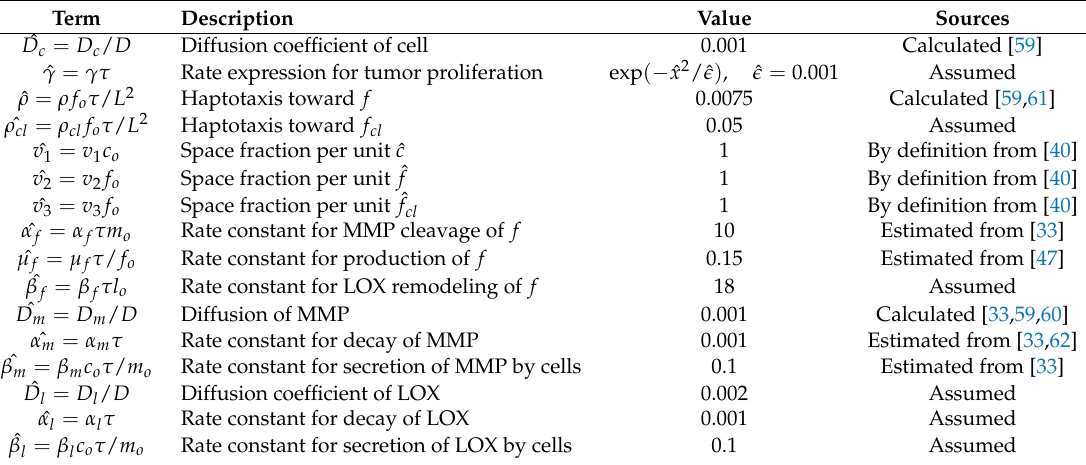
Table 2. Dimensionless expression and values of parameters used in M ATLAB simulation of metastatic invasion of cancer through a remodeling